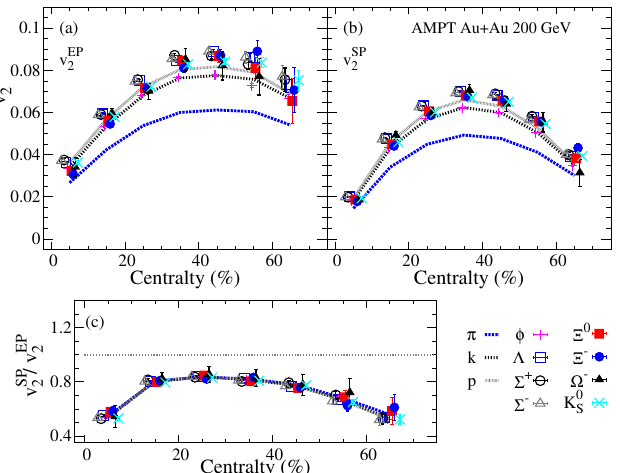
Figure 3. The identified particles centrality dependence of the elliptic flow harmonic with respect to participant and spectator event planes panels ( a , b ) respectively. The elliptic flow fluctuations represented by the ratio v SP / v EP are presented in panel ( c ) for Au+Au collisions at 2 2 from the AMPT model.